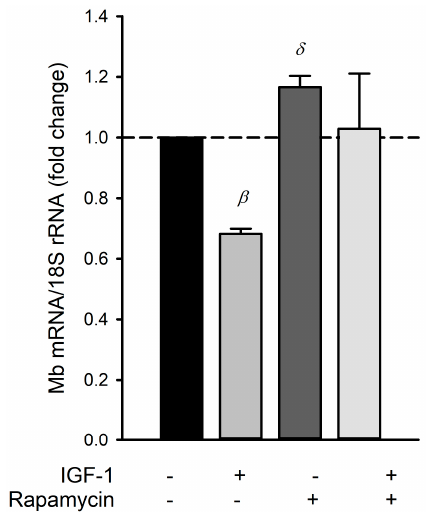
Figure 5. IGF-1 inhibits Mb mRNA expression, which can be restored by inhibition of mammalian target of rapamycin (mTOR). Mb mRNA expression levels relative to control for myotubes treated for 24 h with IGF-1, myotubes treated with rapamycin or a combination. Myotubes were cultured under 20% O 2 . β : significant effect of IGF-1 treatment; δ : significant effect of rapamycin treatment. Values are given as mean ± SEM, n = 4.